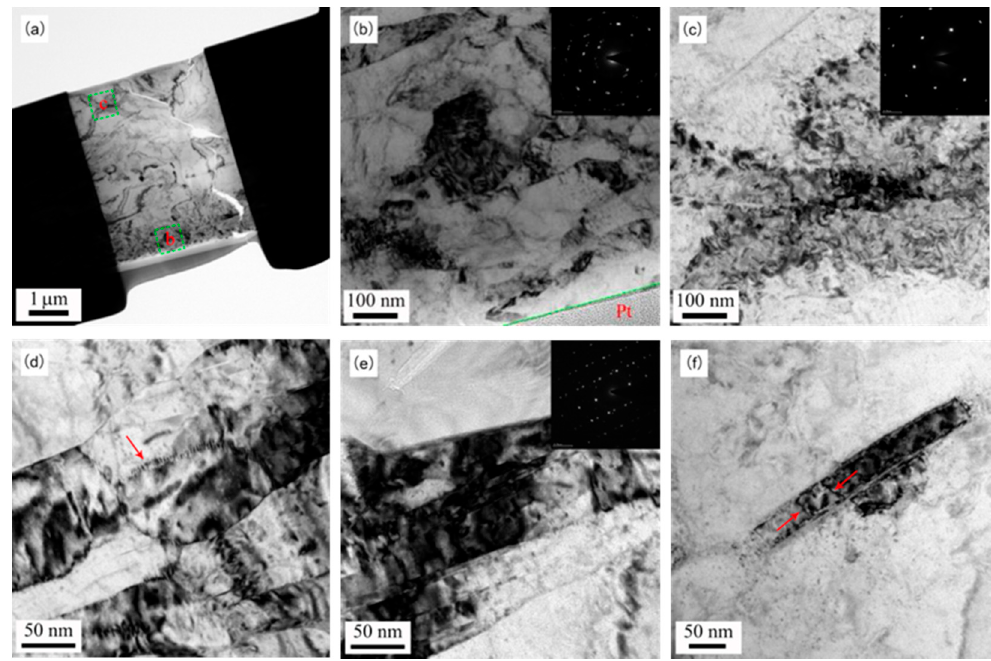
Figure 4. The cross-sectional morphology of alloy 690 after USRT. ( a ) A gradient refinement nanograin (NG) layer; ( b ) magnified view of ( a ); ( c ) dislocation entanglement; ( d ) dislocations activated and hindered near the grain boundary; ( e ) twins formation; and ( f ) fine grains production.